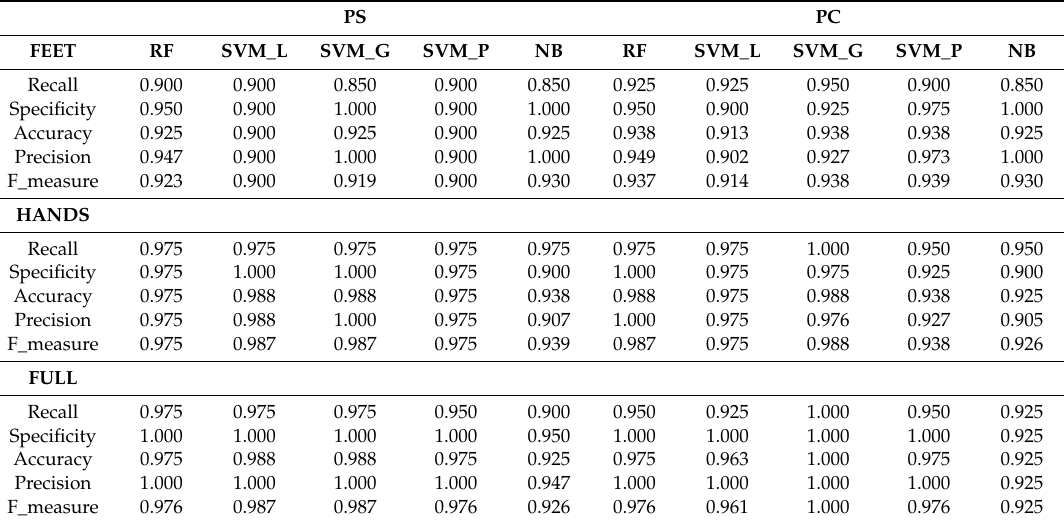
Table 5. Classification Results for Post-Significance and Post-Correlation datasets.